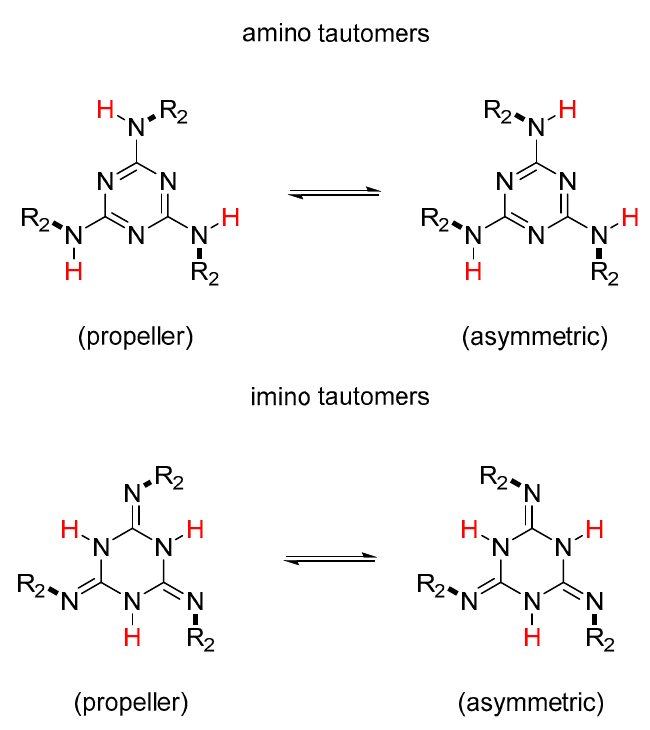
Scheme 3. Border cases of the possible tautomers and corresponding isomers.